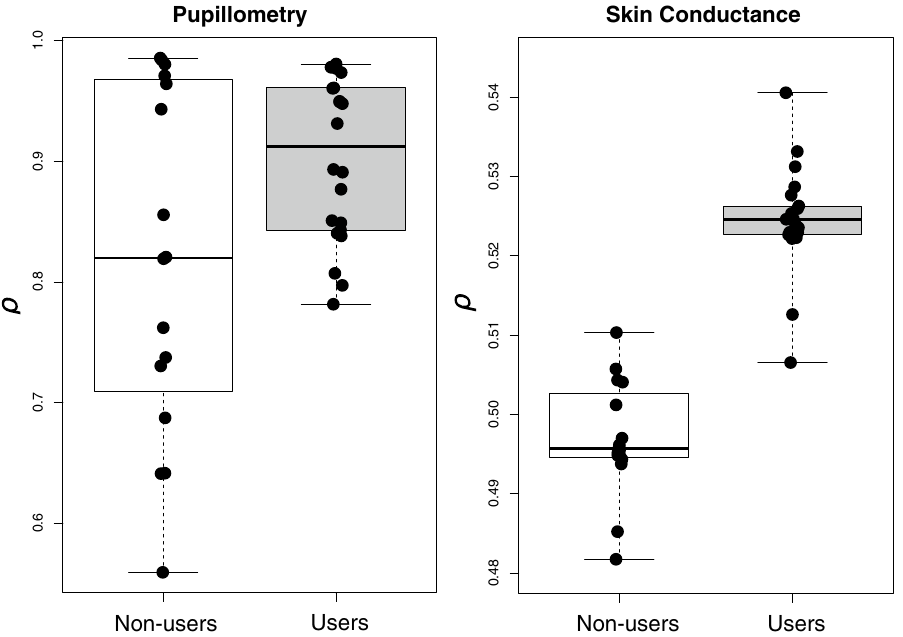
Figure 4. Effects of instructed rule reversals on fear learning ( ρ ) in subjects with and without history of psychedelic drug